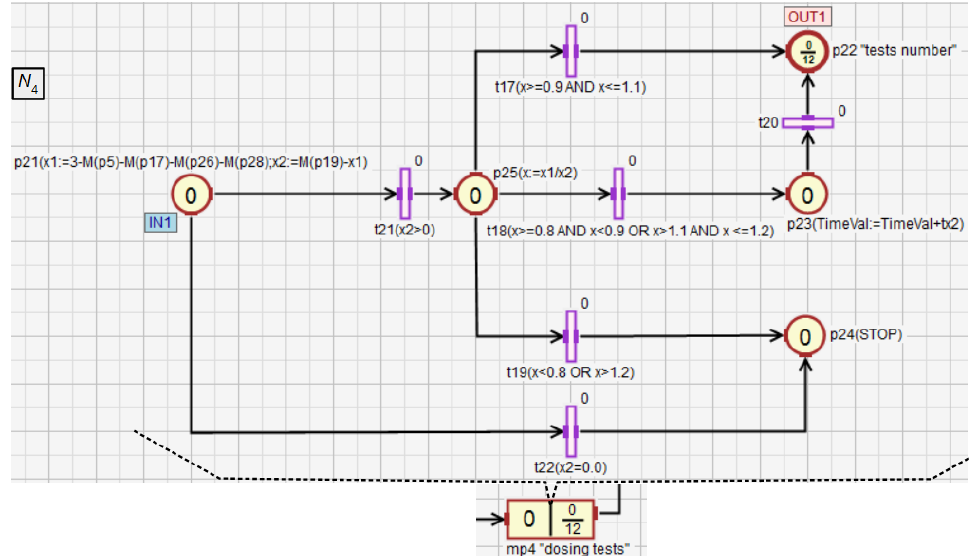
Figure 15. The module checking whether the liquids L 1 and L 2 are transferred to the mixer at a similar speed.